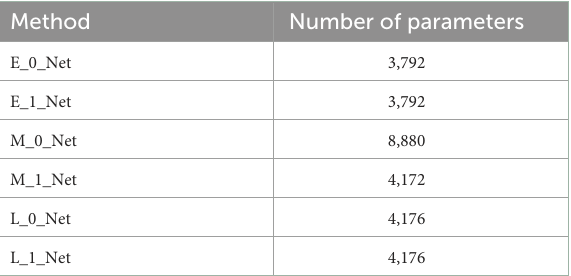
TABLE 1 The number of all